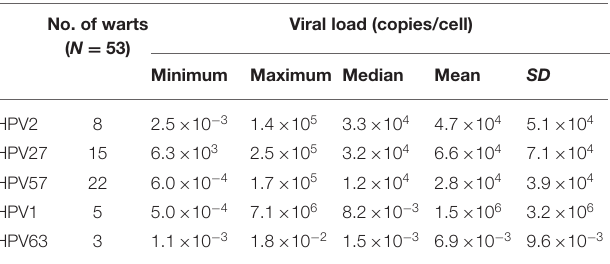
TABLE 3 | Estimated viral loads in 53 randomly selected warts with single human papillomavirus (HPV) infections.